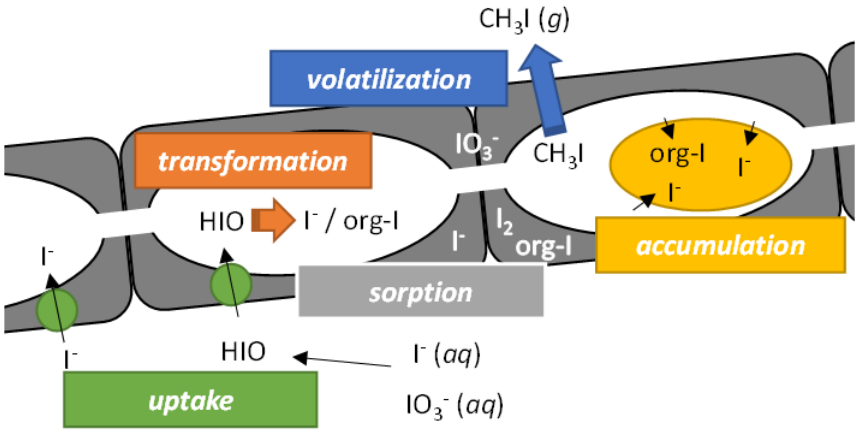
Figure 2. Possible interactions between iodine and microscopic filamentous fungi. Ban-nai et al. [21] identified eleven filamentous fungal strains, including strains of basidiomycetes, ascomycetes, and fungi imperfecti, which were capable of emitting the methyl-iodide. Ban-nai et al. [21] also suggested that fungi have comparable volatilization potential to soil bacteria. Redeker et al. [22] indicated that the daily iodide emission rate via volatile methyl-iodide significantly varied among species and morphotypes of ectomycorrhizal fungi within the range from 0.15 to 30 µ g · g − 1 of fungal dry biomass at 0.2 mmol · L − 1 iodide concentration. Aqueous and gaseous sampling revealed that methyl- iodide is only produced in presence of active organisms, since, reportedly, no iodide was transformed in sediments under abiotic conditions [23].